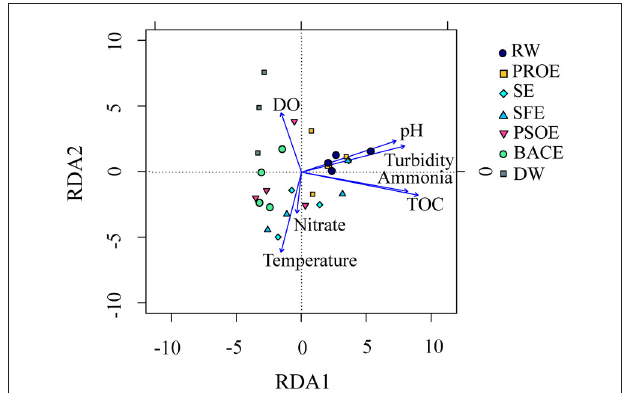
FIGURE 9 | Redundancy analysis (RDA) of main bacterial phyla and environmental parameters. The abbreviations of the samples are the same as used in Table 2